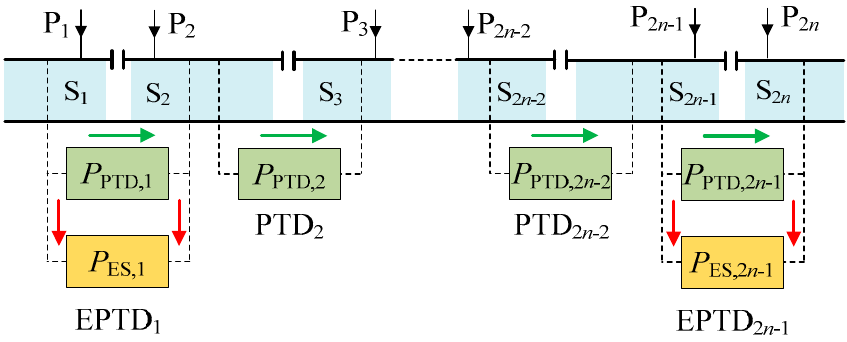
Figure 6. The simplified electrical description for regenerative braking energy (RBE)